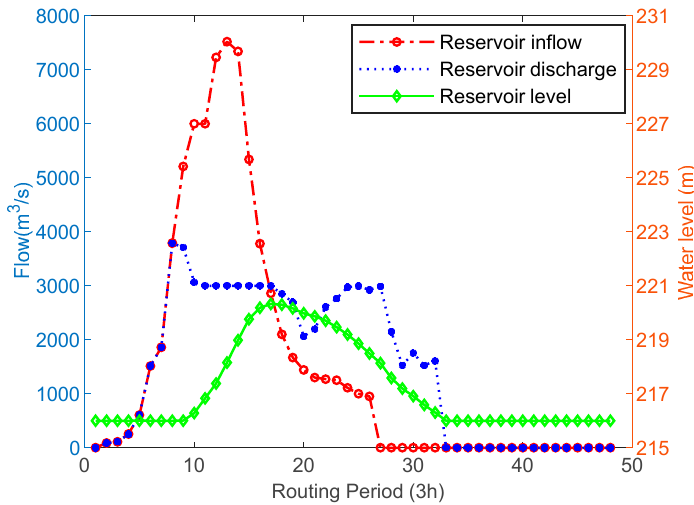
Figure 8. Operation process using CF-BES for reservoirs in Luanhe River Basin.